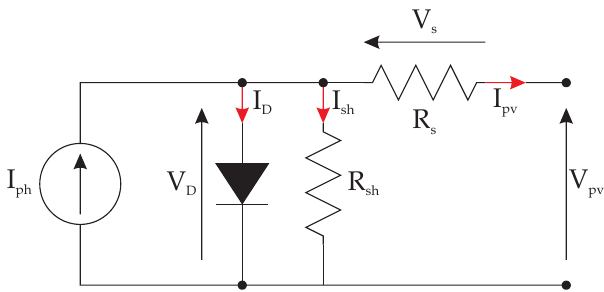
Figure 2. Single-diode PV